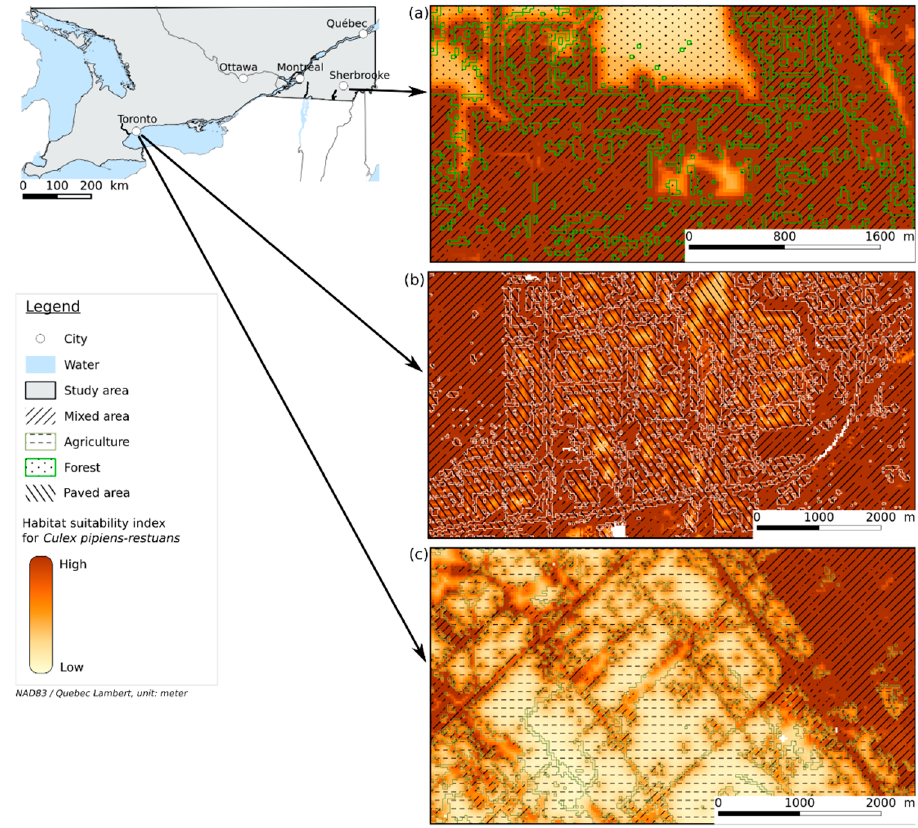
Figure 4. Blown-up views of the HS map showing the interface between ( a ) mixed area and forest, ( b ) mixed area and paved area, and ( c ) mixed area and agriculture.